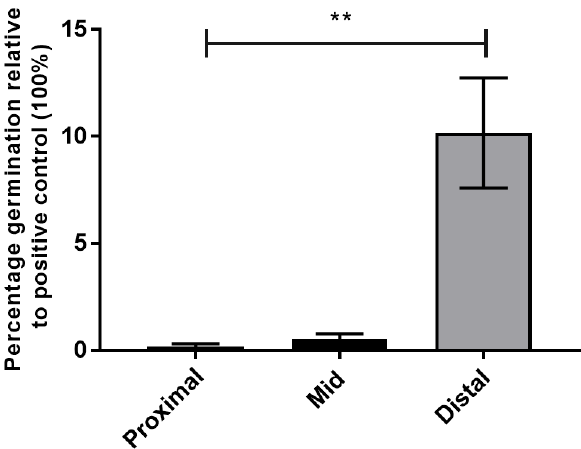
Figure 2. Spores of NTCD T7 germinate in the small intestine of hamsters. Spores were incubated in the contents of fluid taken from proximal, mid and distal portions of non-antibiotic-treated hamsters ( n = 6) for 1 h at 37 °C anaerobically. Data are presented as percent germination, determined by: (CFU from germinated spores pre-incubated in intestinal fluid/CFU from germinated spores pre-incubated in 0.1% taurocholate) × 100. Error bars represent the standard deviation (SD). The data were analysed by nonparametric ANOVA (Kruskal –Wallis) with Dunn’s uncorrected comparison. Statistical difference p value: ** p = 0.0017.